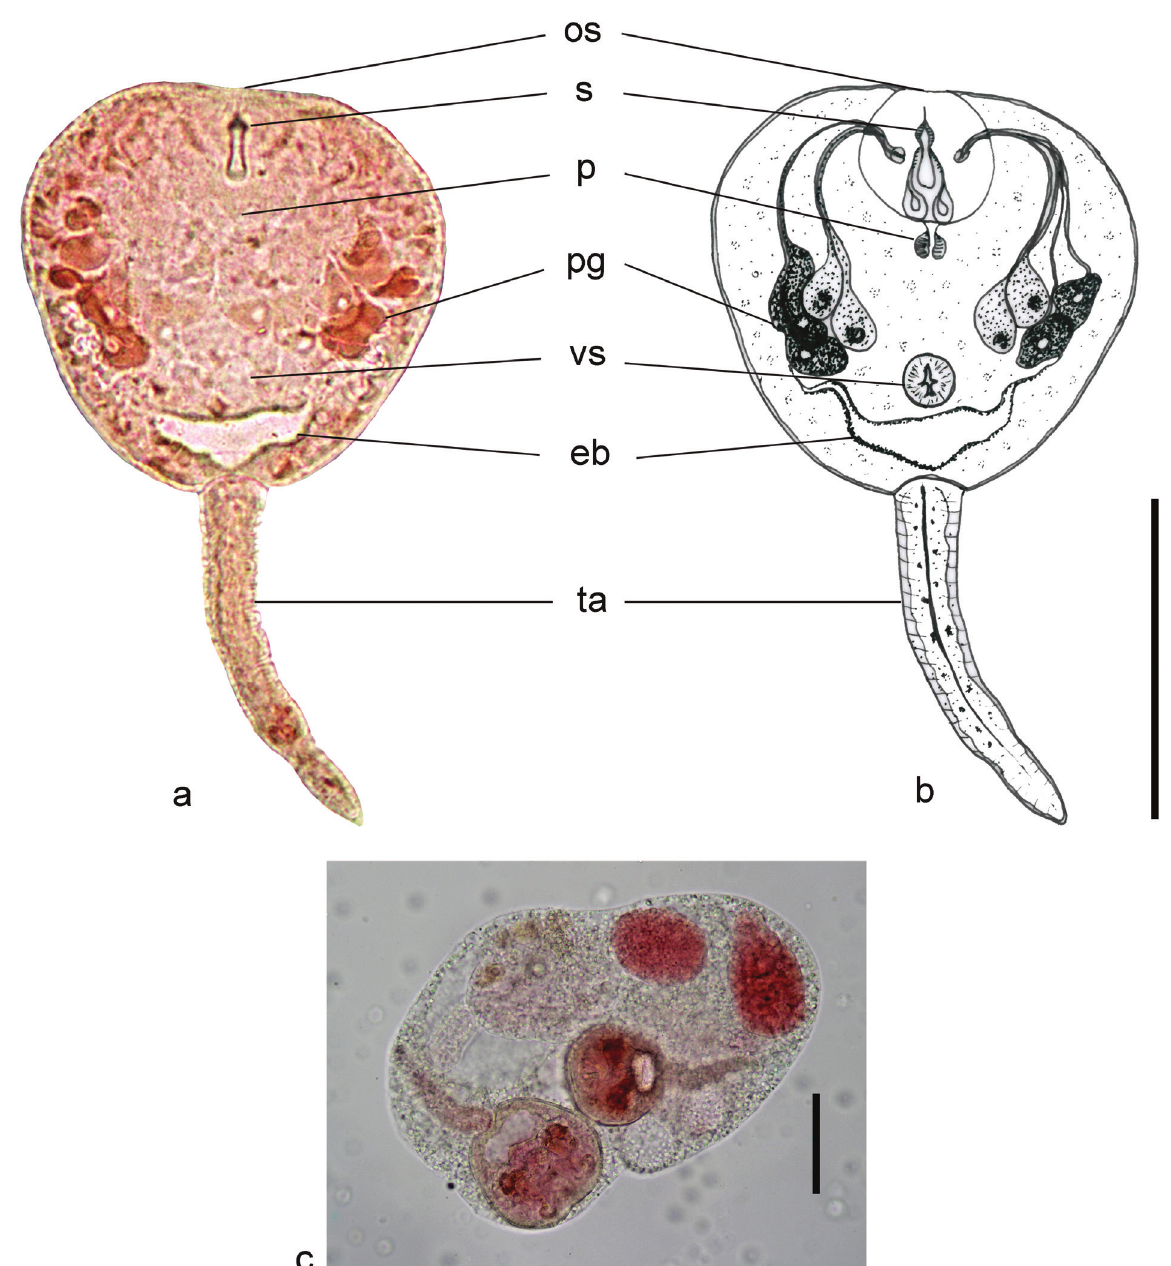
Figure 4. Loxogenes liberum Seno, 1907. a . specimen stained with 0.5% neutral red. b . drawing of cercaria. c . sporocyst stained with 0.5% neutral red. Abbreviations – eb: excretory bladder; os: oral sucker, p: pharynx, pg: penetration gland, s: stylet; ta: tail; vs: ventral sucker. Scale bars: 50